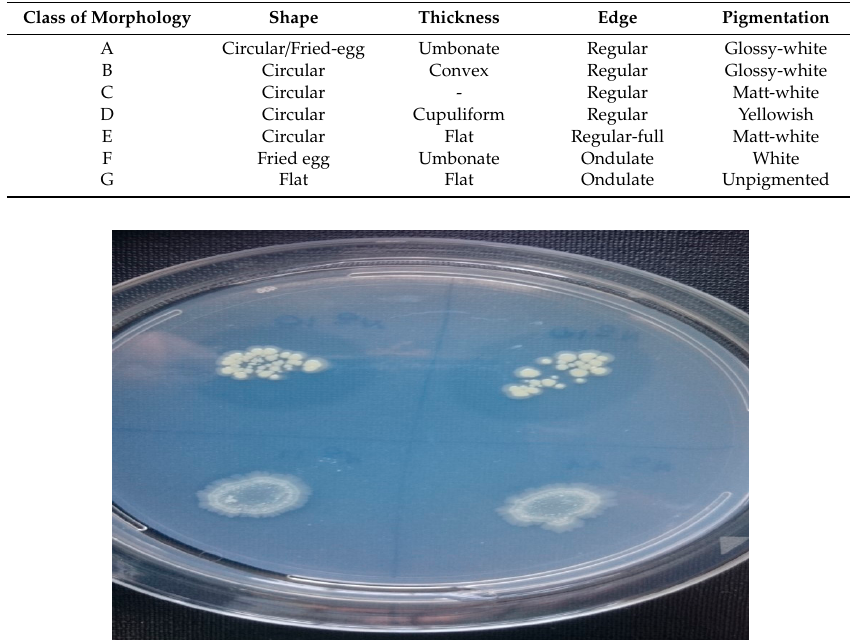
Figure 1. Phosphorous solubilization activity of bacterial isolates on the plate assay with the National Botanical Research Institute Phosphate-medium, in which translucent halos around the P-solubilizing colonies are visible. Table 5. Class of morphology, Gram reaction and presence ( + ) or absence (-) of siderophore production and P-solubilization activity of the 35 selected bacterial